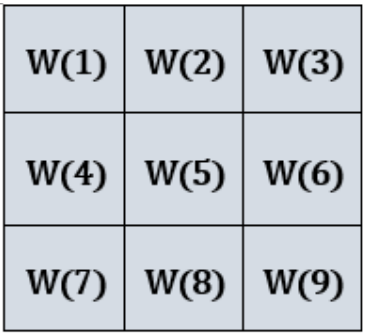
Figure 3. Projection window to contain noise.